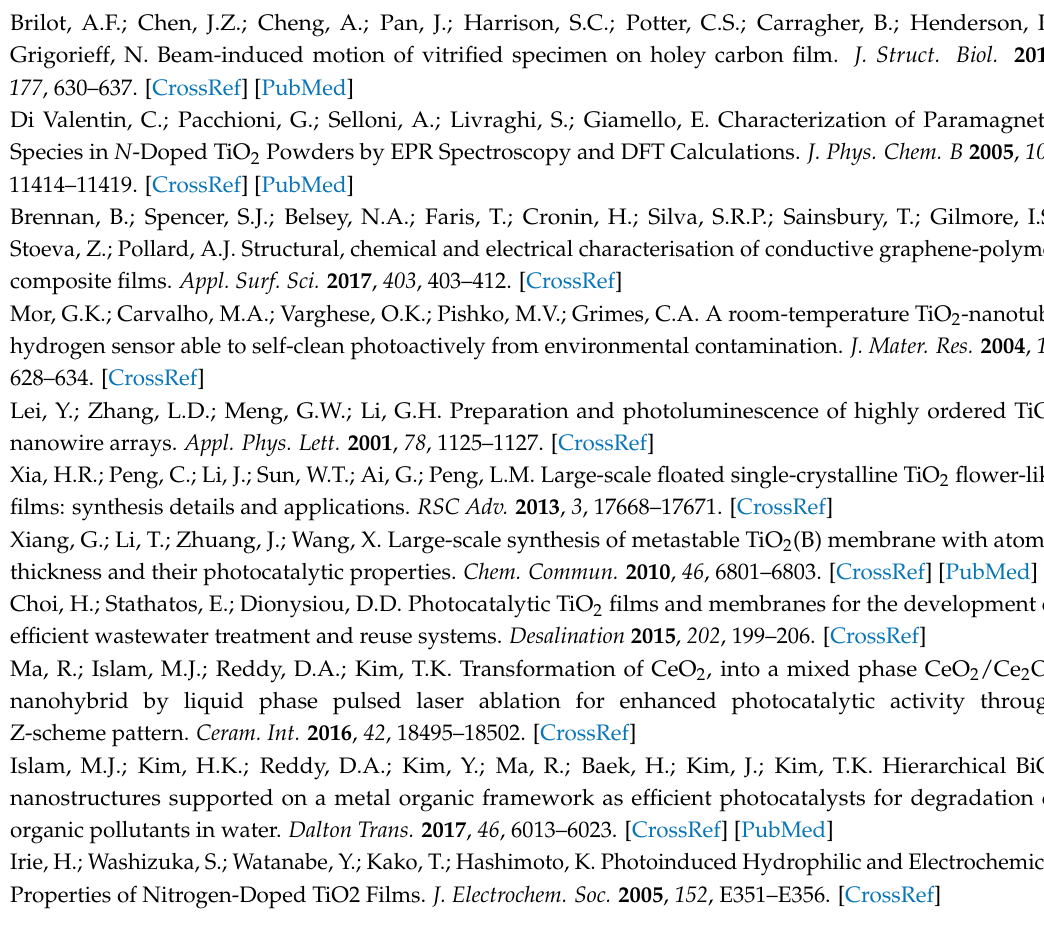
Figure S1. UV-Vis diffuse reflectance spectroscopy of S0, SAg-UV, SAg-HY, SAu-UV, SAu-HY and P25 TiO 2 . Table S2. Degradation rate constant of Rhodamine B. Figure S3. Recycling test of the SAg-UV during the degradation of RhB under visible light irradiation. Figure S4. E. coli inactivation with SAg treatment. Figure S5. The evolution of Au or Ag NPs’ particle size after the photocatalytic process. The particle size of Ag and Au NPs increased from 2.3 ± 0.1 nm–13 ± 0.3 nm and from 2.4 ± 0.1 nm–17 ± 0.4 nm,